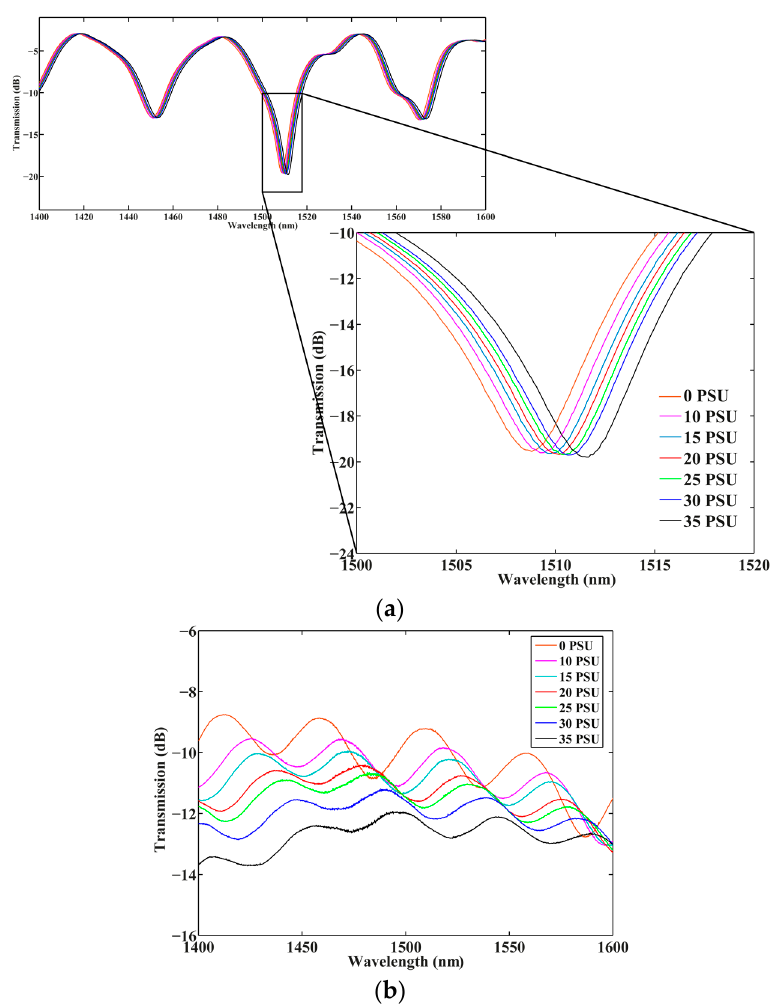
Figure 2. ( a ) Transmission for 25 µm diameter SMS structure uncoated structure as a function of wavelength for different saline concentrations; ( b ) Transmission for 25 µm diameter SMS structure ITO coated structure as a function of wavelength for different saline concentrations.